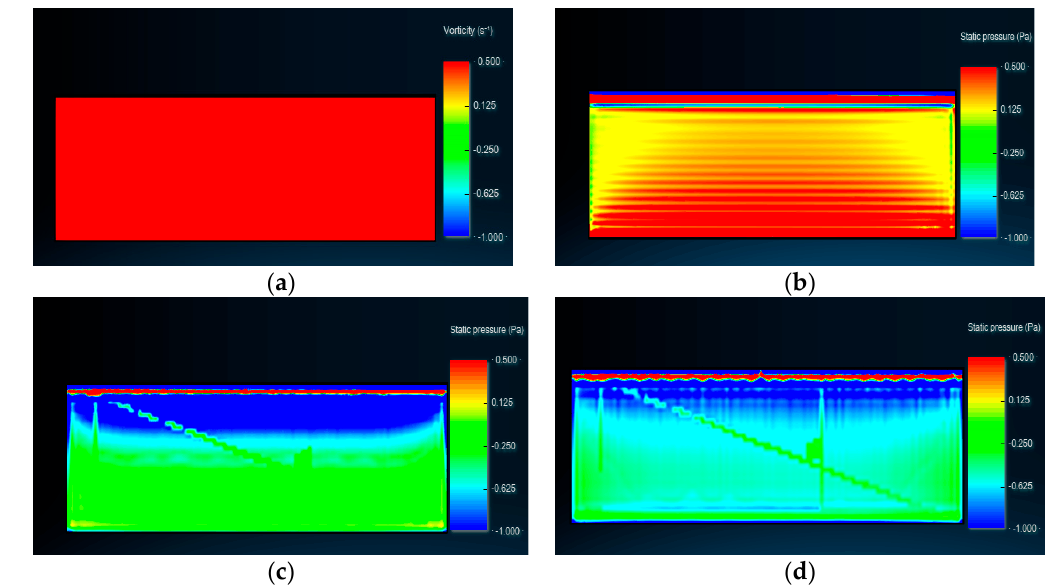
Figure 6. Pressure nephograms of several bionic wings’ surface: ( a ) wing e, ( b ) basic wing, ( c ) wing c, and ( d ) wing i.